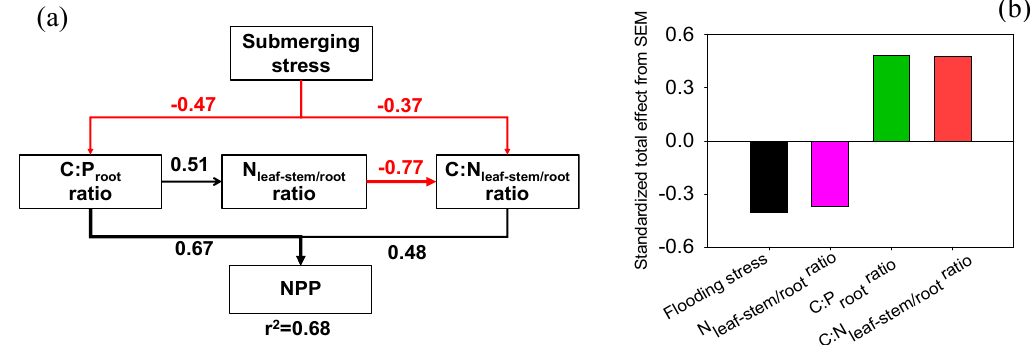
Figure 6. Structure equation modeling (SEM) with variables (boxes) and potential causal relationships (arrows) for NPP ( a ) and standardized total effects (direct effect plus indirect effect) on NPP derived from SEM ( b ). The black-headed arrows indicate that the hypothesized direction of causation is a positive relationship; on the contrary, the red-headed arrows represent a negative relationship. Arrow width is proportional to the strength of path coe ffi cients. Standardized path coe ffi cients (numbers) can reflect the importance of the variables within the model [24]. The model for NPP had χ 2 = 2.660, df = 3, p = 0.447, RMSEA = 0.000, AIC =